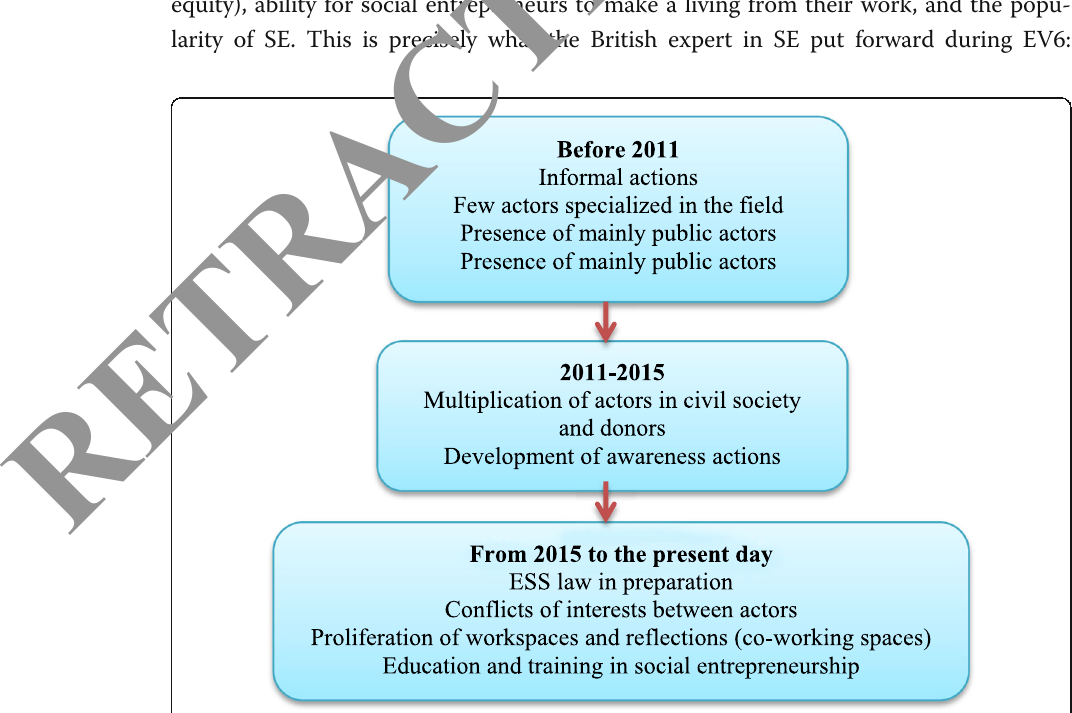
Fig. 2 Evolution of social entrepreneurship in Tunisia. Source: